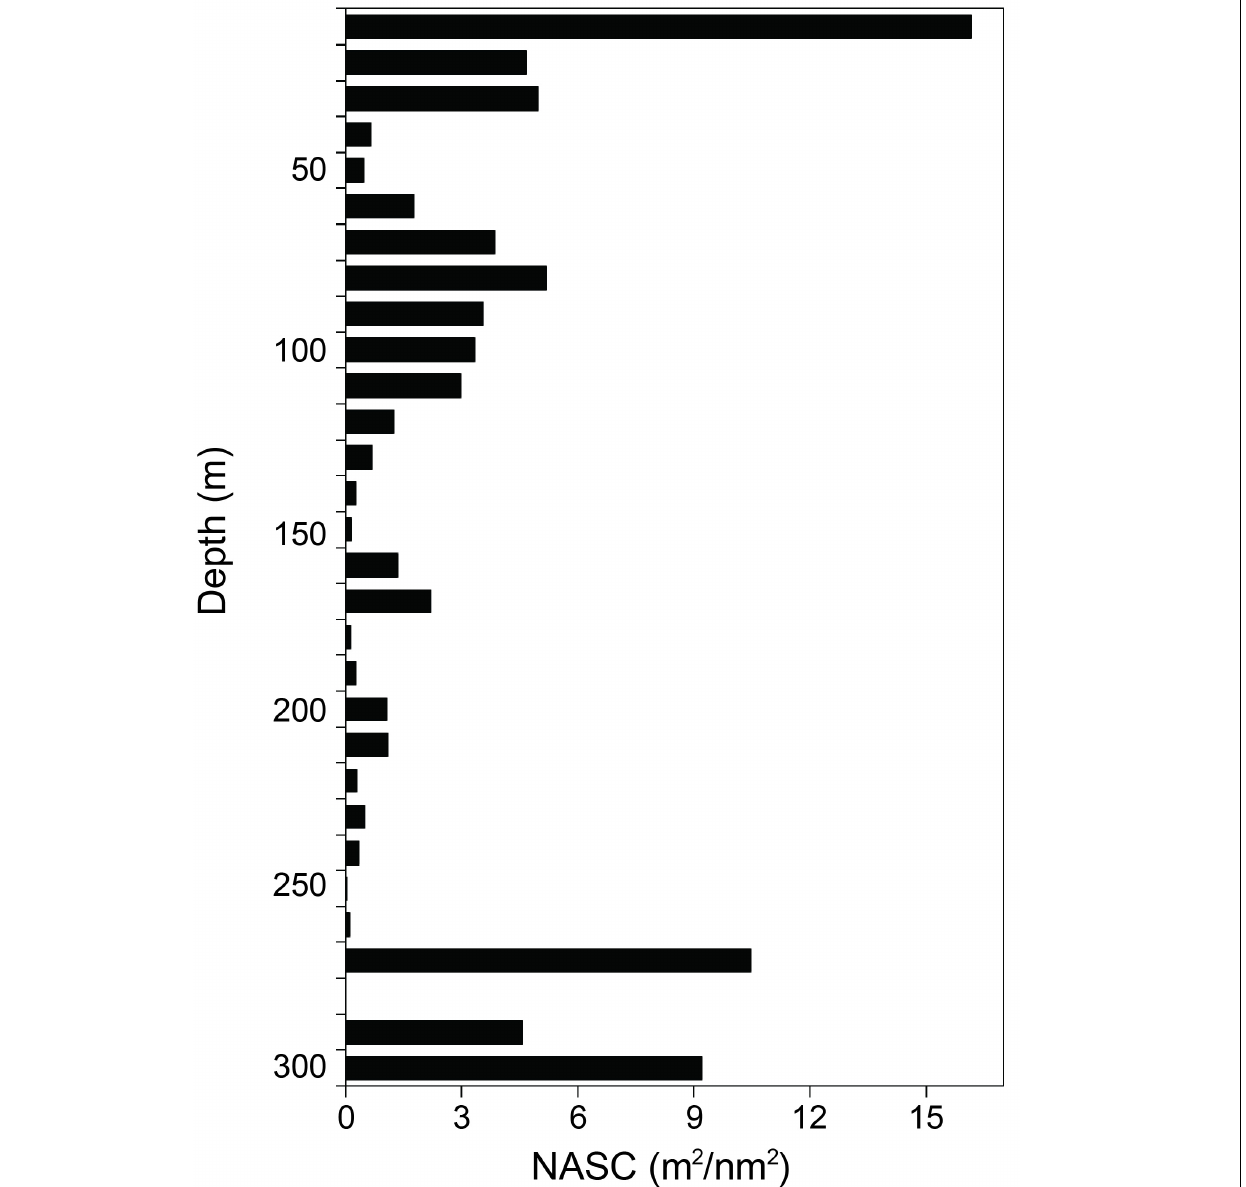
The Spearman’s rank order correlation was calculated between the NASC values and the environmental parameters. The relationship between the NASC values of the low-value areas and the environmental parameters extracted from the locations of the low-value areas and the relationship between the NASC values of the high-value areas and the environmental parameters extracted from the locations of the high-value areas were assessed. In the low-value areas, there was a weak negative correlation between the NASC value and the temperature ( r s = − 0.227, n = 718, p < 0.01) and a very weak negative correlation